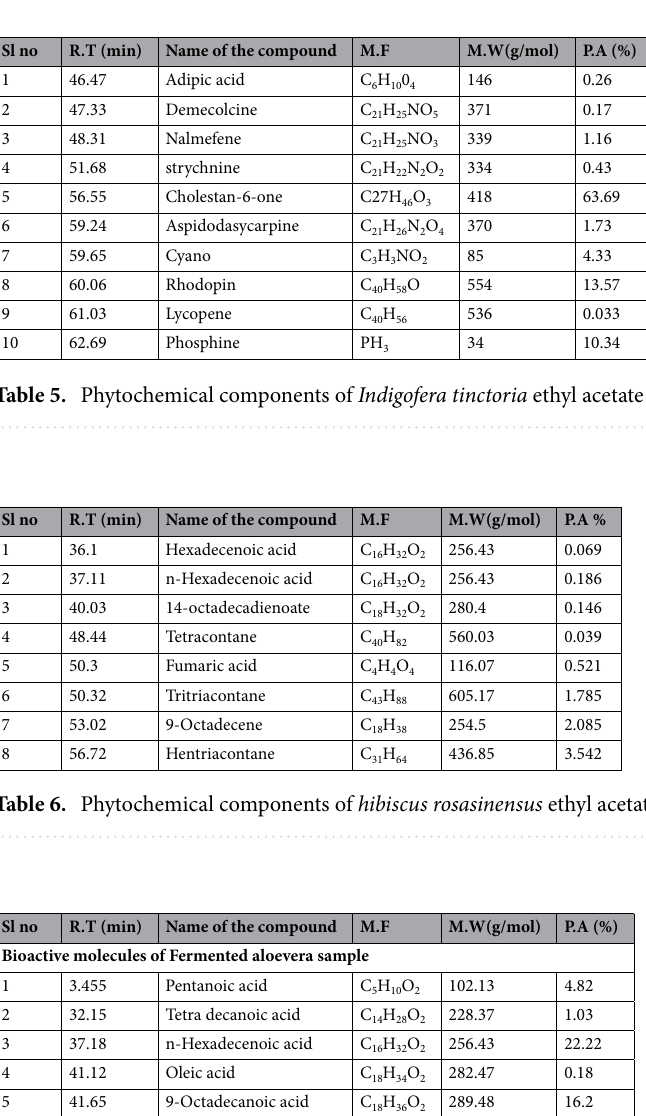
Table 7. Phytochemical components of Aloe vera ( Xanthorroeaceae) ethyl acetate fraction by GC–MS.